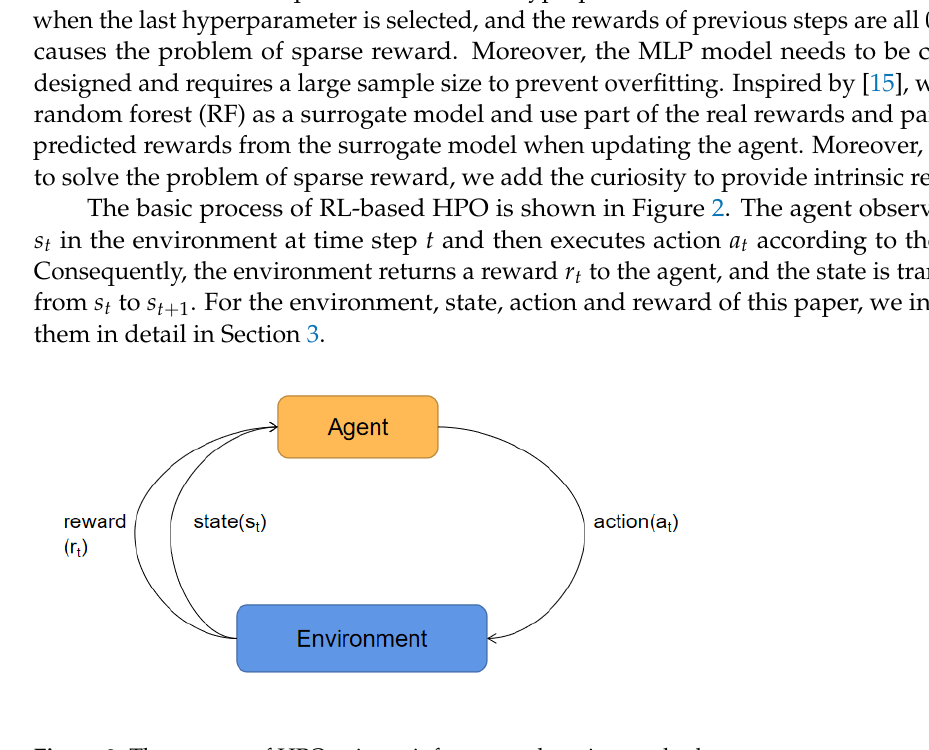
Figure 2. The process of HPO using reinforcement learning